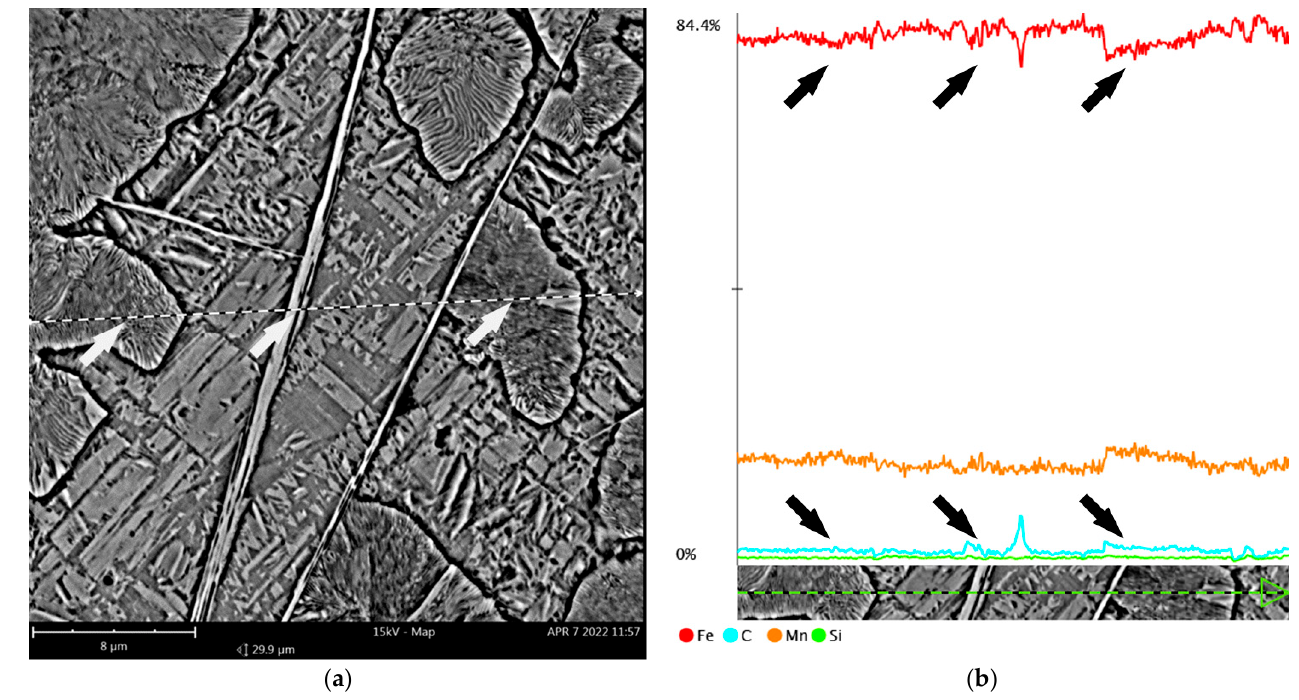
Figure 8. EDX surface microanalysis results: ( a ) area of analysis; ( b ) graphical distribution of the analysed elements; ( c – f ) the individual elemental distributions arranged sequentially as C, Fe, Mn and Si; ( g ) the energy spectrum of the X ‐ rays obtained from the area analysed. SEM (EDS).